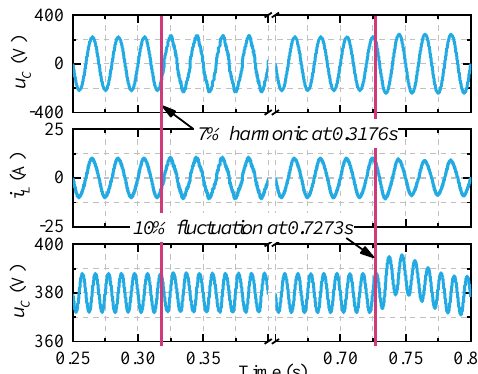
Figure 5. Input current and capacitor voltage waveforms on input voltage fluctuation and harmonic injection.